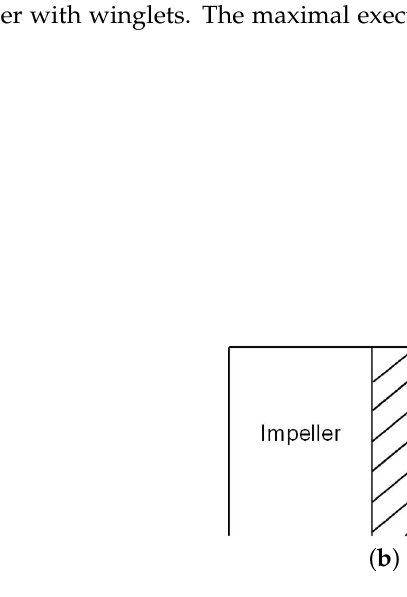
Figure 4. ( a ) Vortex pump according to the open design; and ( b ) schematic illustration of the open design.